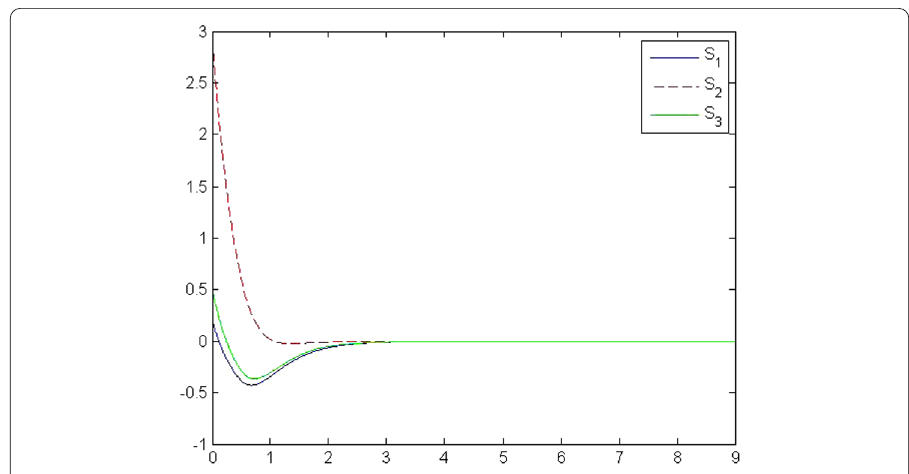
Figure 4 The sliding-mode surface function S k ( t ) ( k = 1,2,3) in mode 2